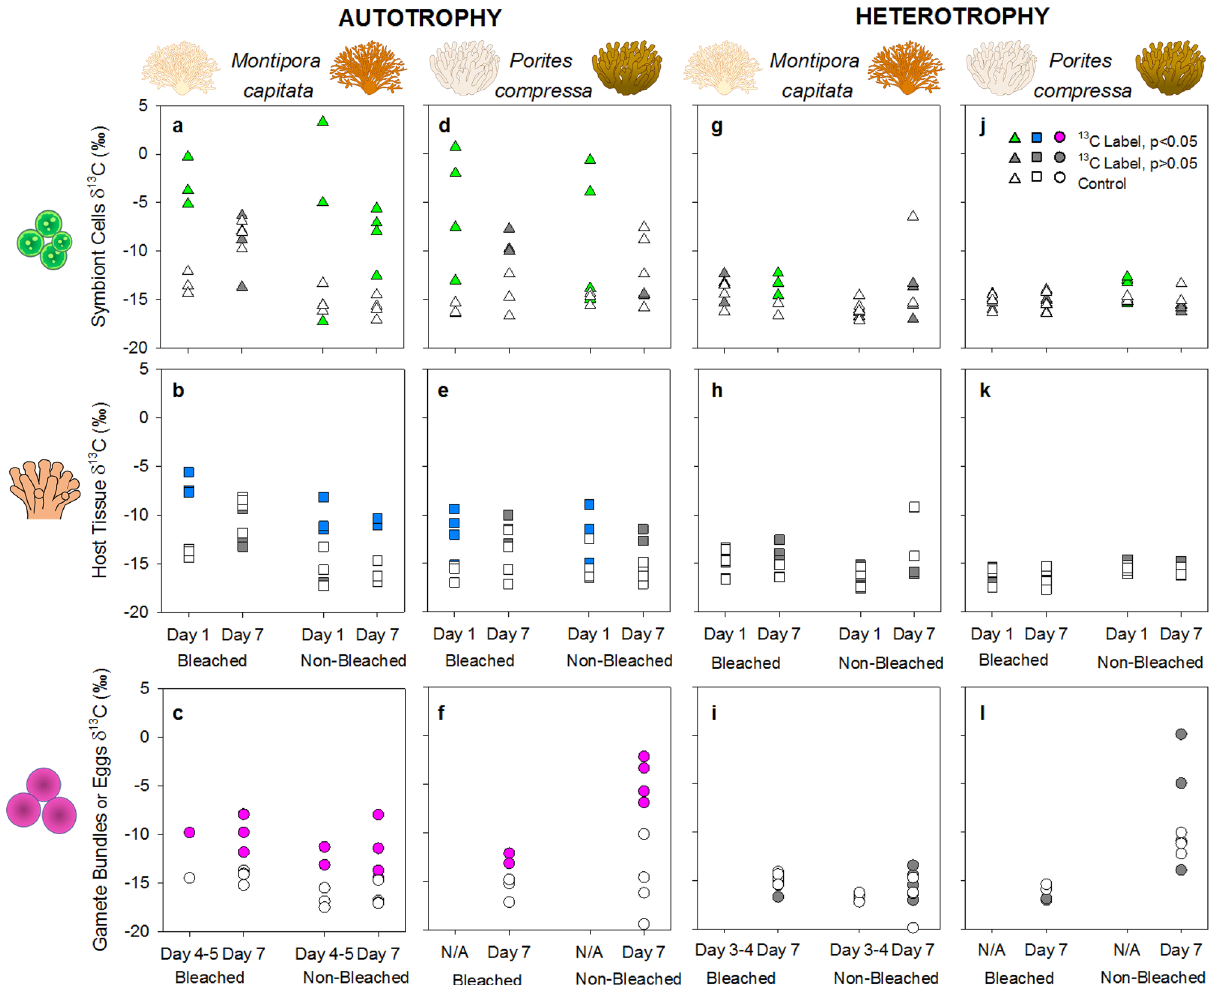
Figure 2. Carbon acquisition for gamete development is predominantly autotrophic. ( a – l ) Acquisition of carbon by autotrophy or heterotrophy in Montipora capitata ( a – c, g – i ) and Porites compressa ( d – f, j – l ) colonies. Allocation occurred during the chase phase to symbiont cells ( a, d, g, j ), host tissue ( b, e, h, k ), and eggs ( c, f, i, l ) for each species. All stable carbon isotopic values (δ 13 C) are shown; with control colonies (DI 12 C or 12 C-rotifers) in white symbols; labeled colonies (DI 13 C or 13 C-rotifers) in colored symbionts. Green, blue, or pink symbols indicate statistically significant differences compared to control colonies; and labeled colonies in grey symbols indicate no significant difference compared to control colonies. Complete statistical analyses can be found in Supplementary Tables